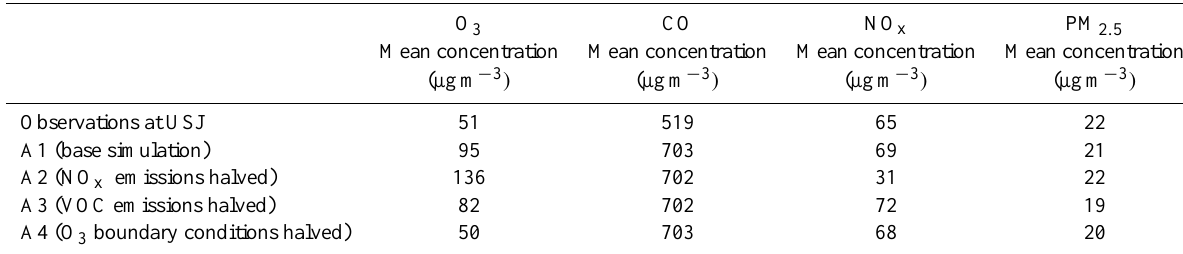
Table 3. Results from simulations A1 to A4 from 2 to 18 July 2011 at USJ. O 3 CO NO x PM 2 . 5 Mean concentration Mean concentration Mean concentration Mean concentration (µgm − 3 ) (µgm − 3